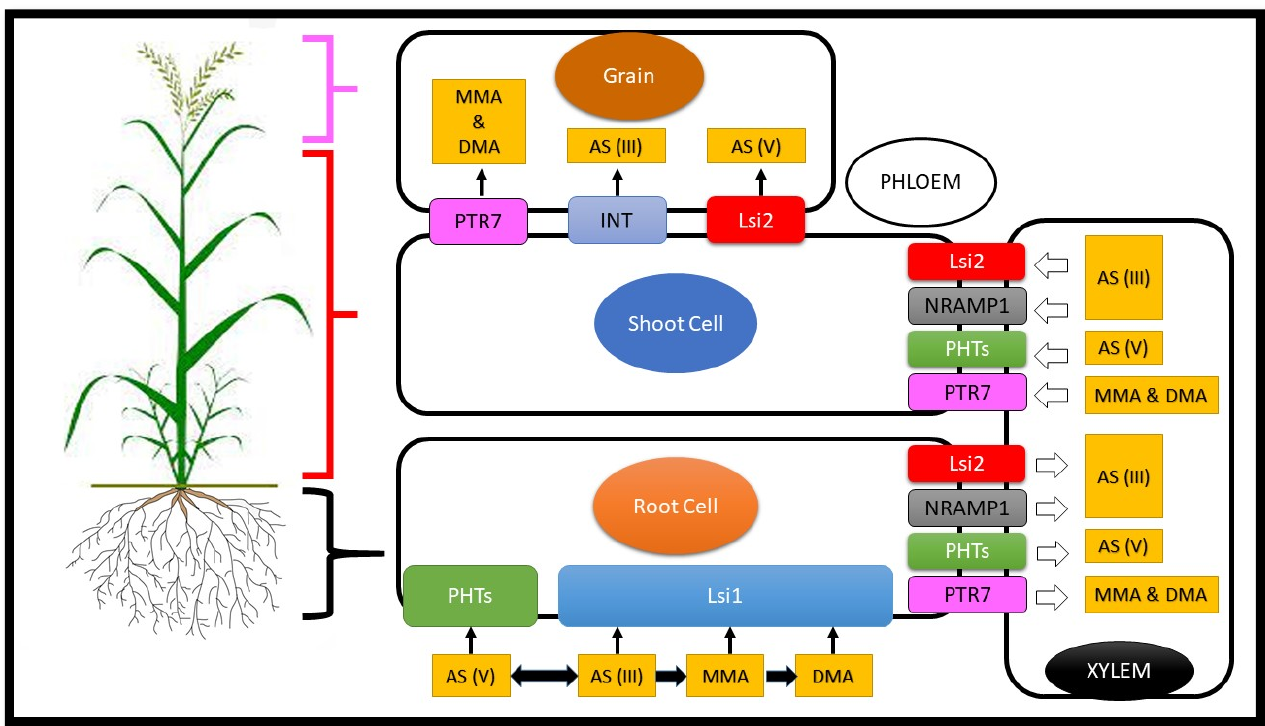
Figure 1. Mechanisms of arsenic uptake, transport, accumulation, and distribution in rice. Nomenclature is as proposed by Shinde and Kumar [30] with some modifications.